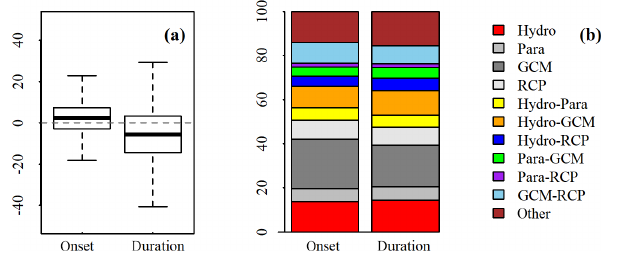
Figure 9. (a) Projected change (days) in the onset and duration of the wet season in SBC; positive (negative) values indicate later (ear- lier) onset or longer (shorter) duration of the wet season; (b) rela- tive contributions (%) of the uncertainties of the projected changes in seasonality. Hydro: hydrologic models; Para: hydrologic model parameters; GCM: general circulation model; RCP: representative concentration pathway (emission scenarios); “other” is the uncer- tainty from the third and fourth orders of interactions between the four major sources (i.e., GCMs, RCPs, hydrologic models, and pa-